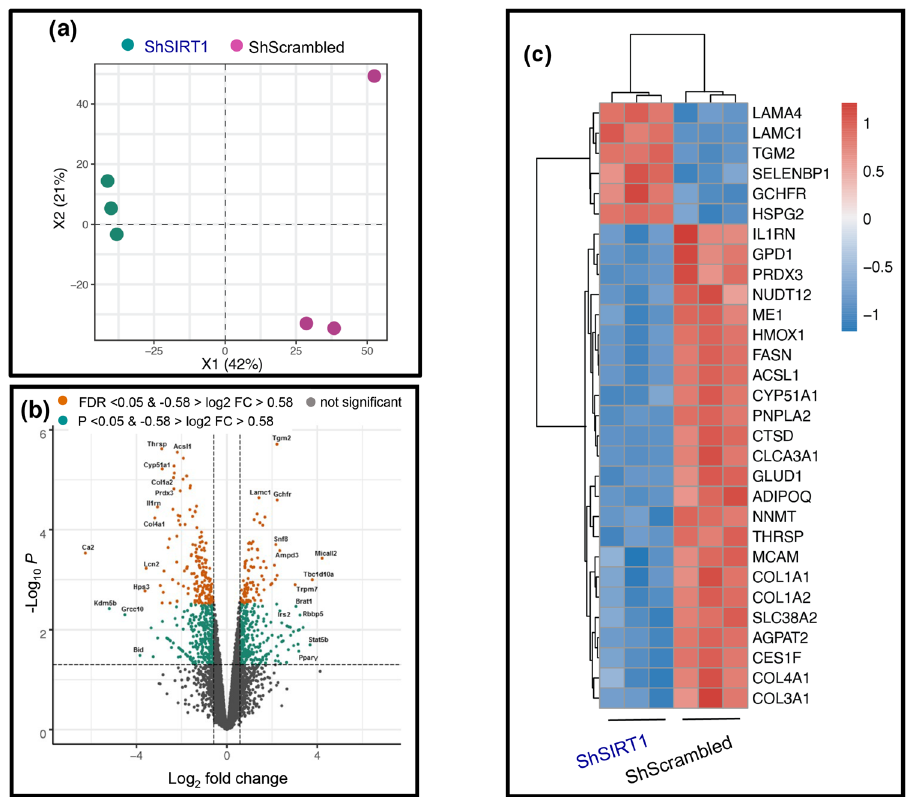
Figure 2. Quantitative proteomics identified altered expression levels of key molecules linked to adipocyte function in SIRT1-depleted adipocytes. ( a ) Principal component analysis (PCA) plot shows the relationship in overall proteomics profiles upon SIRT1-depletion in three replicates (ShSIRT1; green circles) compared to ShScrambled (purple circles). ( b ) Volcano plot analysis highlights the most significant protein alterations in SIRT1-depleted adipocytes vs ShScrambled adipocytes based on false discovery rate threshold (orange) [FDR q value < 0.05 and − 0.58 > log 2 fold change (FC) > 0.58] and P value threshold (green) [P value < 0.05 and − 0.58 > log 2 fold change (FC) > 0.58]. Highlighted in grey are the filtered non-significant changes, as indicated. ( c ) Heatmap clustering of the thirty most-significant protein alterations in SIRT1-depleted adipocytes vs ShScrambled adipocytes based on fold-change cut-off of > 1.5 and FDR values < 0.01. The color scale of the heatmap represents the log2 ratio of each protein in each